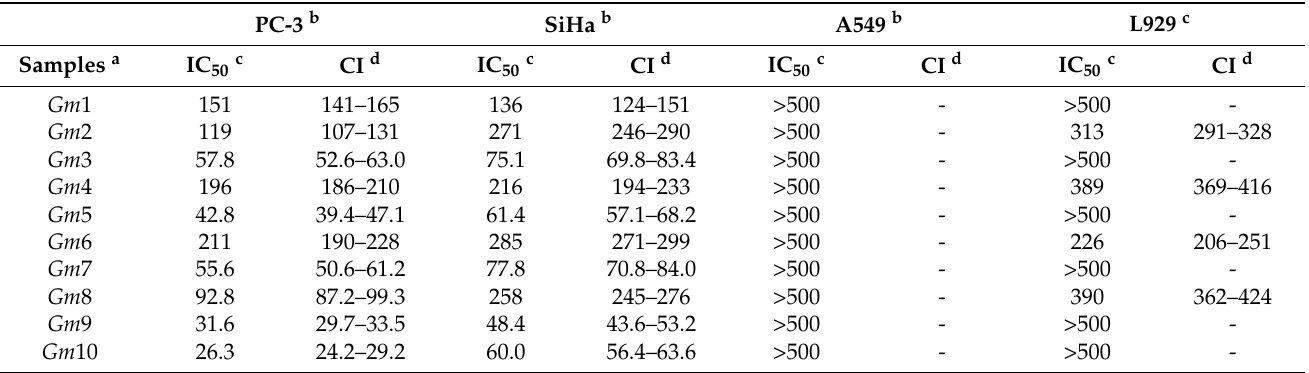
Table 1. Anti-proliferative activity against cancer cell lines and fibroblasts of seed extracts from ten G. monspessulana